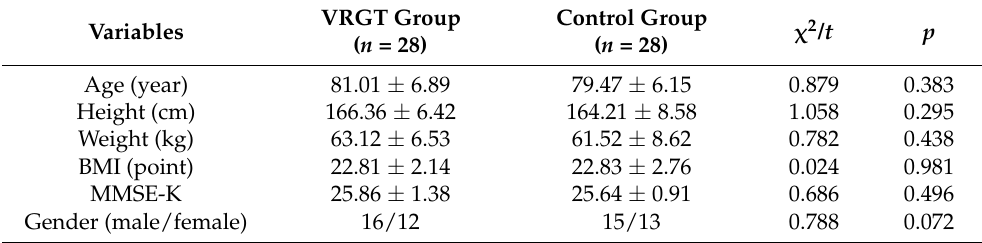
Table 1. General Characteristics of Subject.